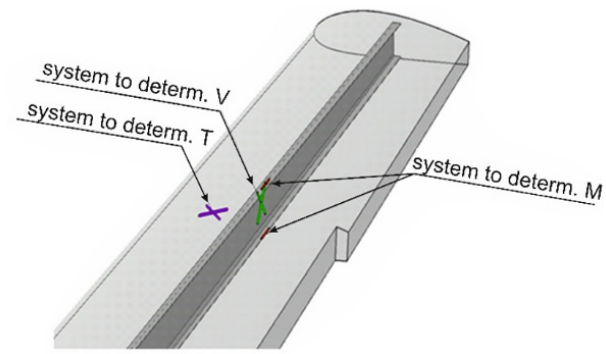
Figure 2. Typical positions of strain gauges making up a system for measuring cross-sectional forces and moments in the wing